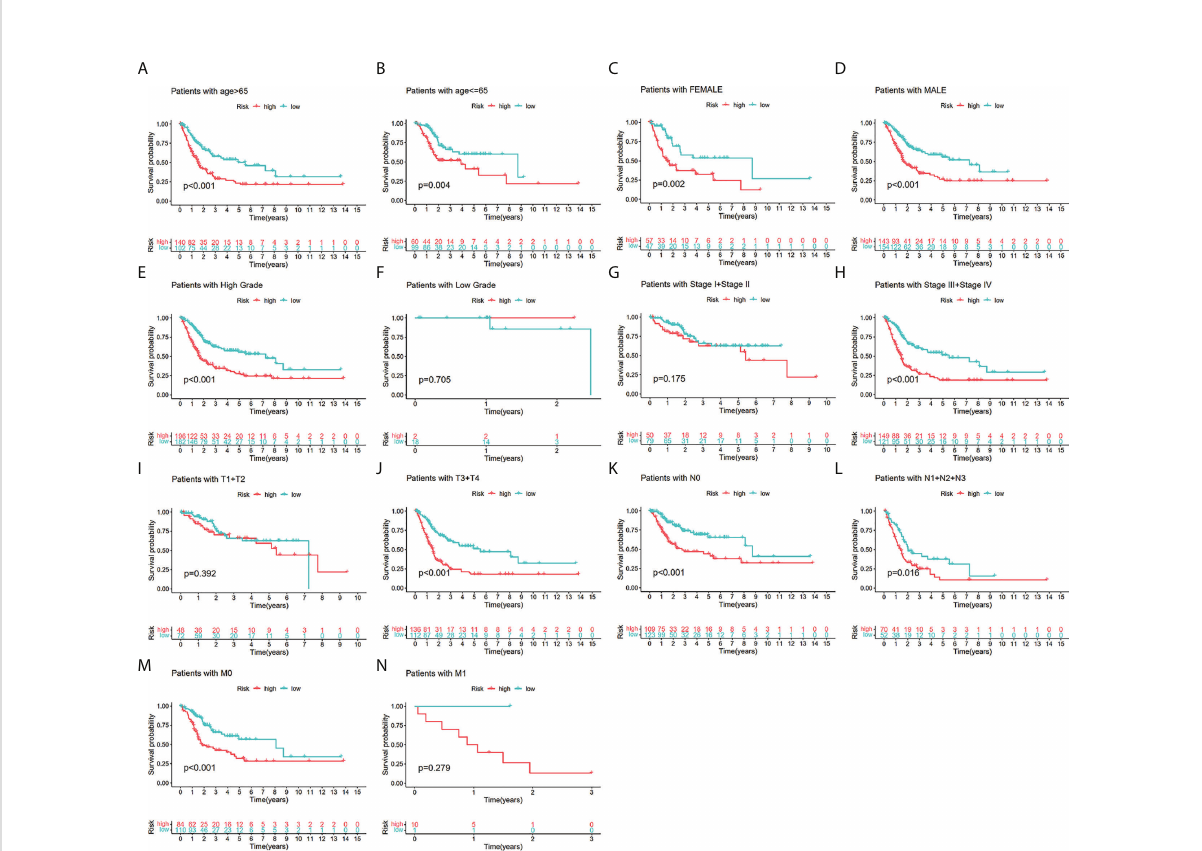
FIGURE 5 The survival outcomes of bladder cancer patients with different risk scores in subgroups of clinicopathological parameters in the TCGA-BLCA. Patients with higher risk scores had worse overall survival compared with those with lower risk scores in most subgroups forage > 65 (A) , age ≤ 65 (B) , female (C) , male (D) , low grade (E) , high grade (F) , low-stage (G) , advanced-stage (H) , low T-stage (I) , high T-stage (J) , nodal metastasis- free (K) , nodal metastasis (L) , metastasis-free (M) and metastasis (N)